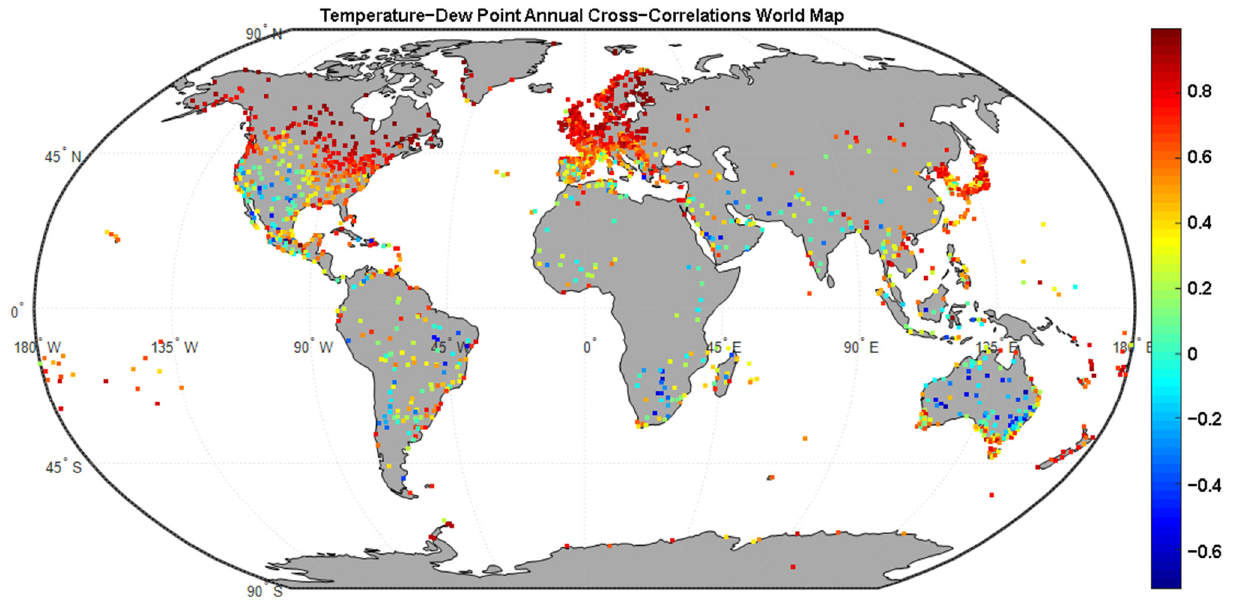
Figure 10. Cross–correlations between global ‐ scale temperature and dew ‐ point records of annual resolution. Results are color coded from red (strong positive) to blue (strong negative) cross–corre ‐ lations.